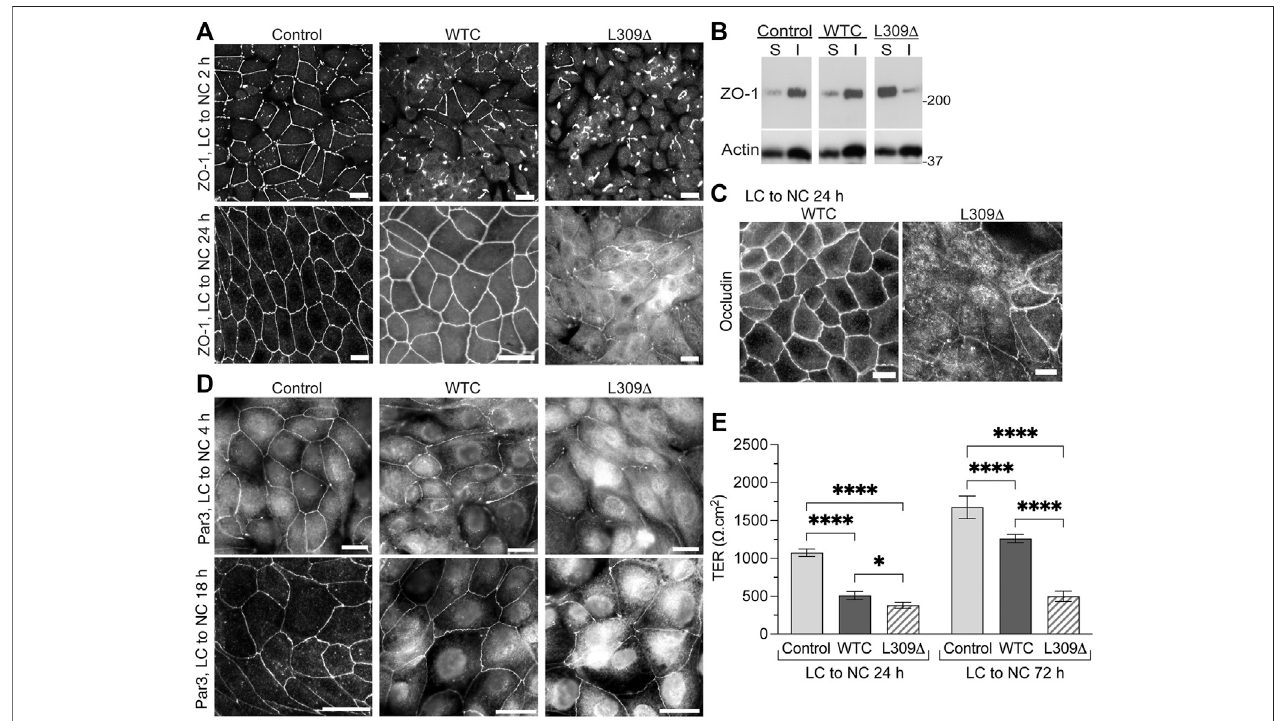
FIGURE 6 | Expression ofthe L309 Δ mutant in MDCK cells induces defects in TJ assembly and barrier function. (A) Distribution of ZO-1 in control MDCK, MDCK- WTCandMDCK-L309 Δ cells2 hor24afterbeingswitchedfromLCtoNCmedium. (B) WesternblotanalysesofZO-1indetergent-soluble(S)and-insoluble(I)fractions prepared from these cells 24 h after the Ca 2+ switch. (C) Distribution of occludin in MDCK-WTC and MDCK-L309 Δ cells 24 h after the Ca 2+ switch. (D) Distribution of Par3 incontrol MDCK, MDCK-WTC and MDCK-L309 Δ cells4 h or18 hafter being switched fromLC toNC medium. For (A – D) ,similarresultswere foundinthree separate experiments. Scale bars = 10 μ m. (E) TERvalues (mean ± SD; n = 8) were measured in control MDCK, MDCK-WTC and MDCK-L309 Δ cells 24and 72 h after the Ca 2+ switch.Datawereappraisedwithtwo-way ANOVA (cell line:F = 519.9, p < 0.0001;effectoftime: F= 357.7, p < 0.0001; interaction: F= 56.3, p < 0.0001)